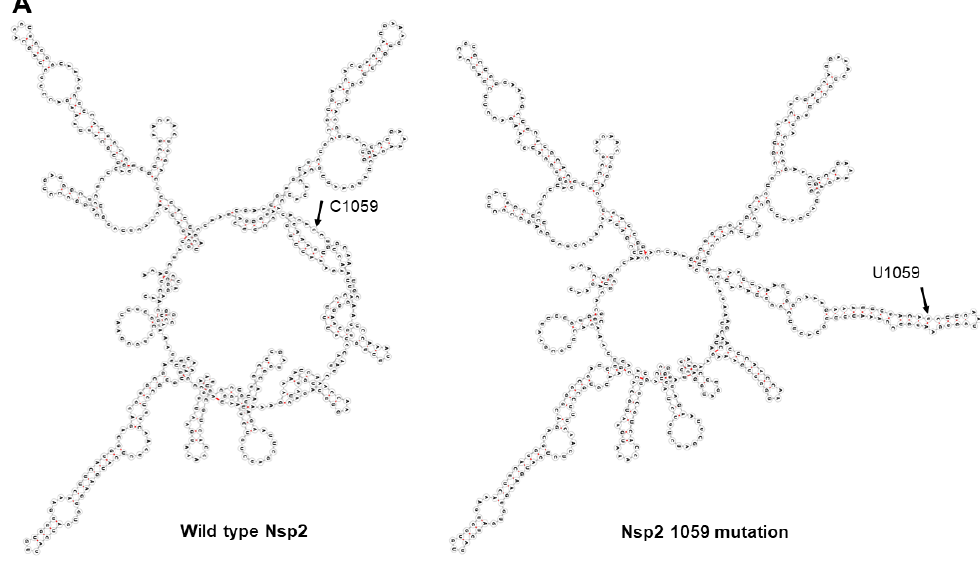
Figure 2. The impact of C1059U mutation on local RNA secondary structure of Nsp2. ( A ) RNA secondary structures of Nsp2 wild type (MFE structure: − 146.10 kcal/mol—centroid structure: − 132.30 kcal/mol) and 1059 mutation (MFE structure: − 147.20 kcal/mol—centroid structure: − 137.80 kcal/mol) using RNAfold tool. ( B ) The base pair probabilities by circular plots with higher base pairing potential is reflected in darker hues of grey lines and the mutated position highlighted by red arrow (MutaRNA). ( C ) The dot plot shows the differences of the base pairing probabilities of 1059 mutation vs. wild type RNA, Pr(bp in WT)—Pr(bp in mut). The base pairs weakened by the 1059 mutation are in blue, while higher base pair probability in the mutant is depicted in red. The mutated position is